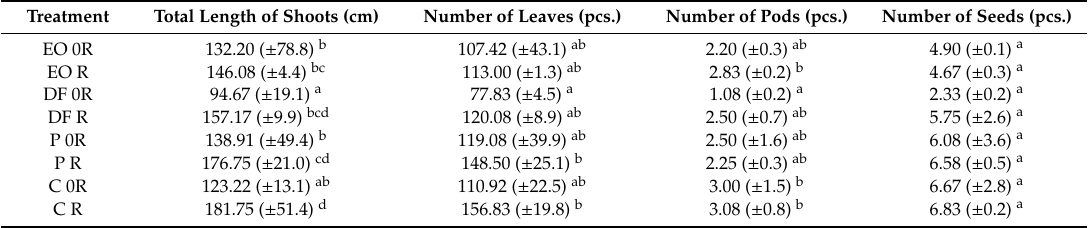
Table1. Thee ff ectofpetroleum-derivedsubstancesandbioremediationonmorphologicalcharacteristics of Vicia faba L. The values are expressed per plant. Treatment